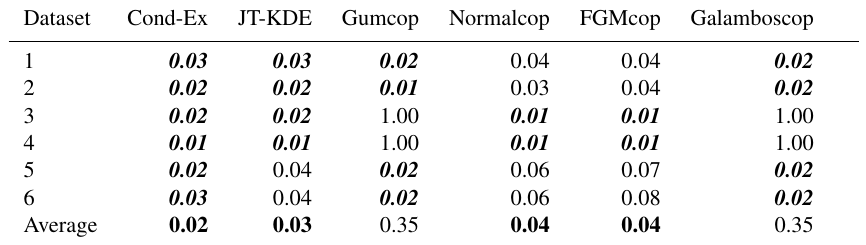
Table 4. Euclidian weighted distance ( wd ) for datasets 1 to 6 based on wind–rainfall and six models, along with confidence scores (average of the wd for datasets 1 to 6). In italic bold are highlighted the values below the naïve approach wd , and the average values of four models with confidence scores <0.1 are highlighted in bold.